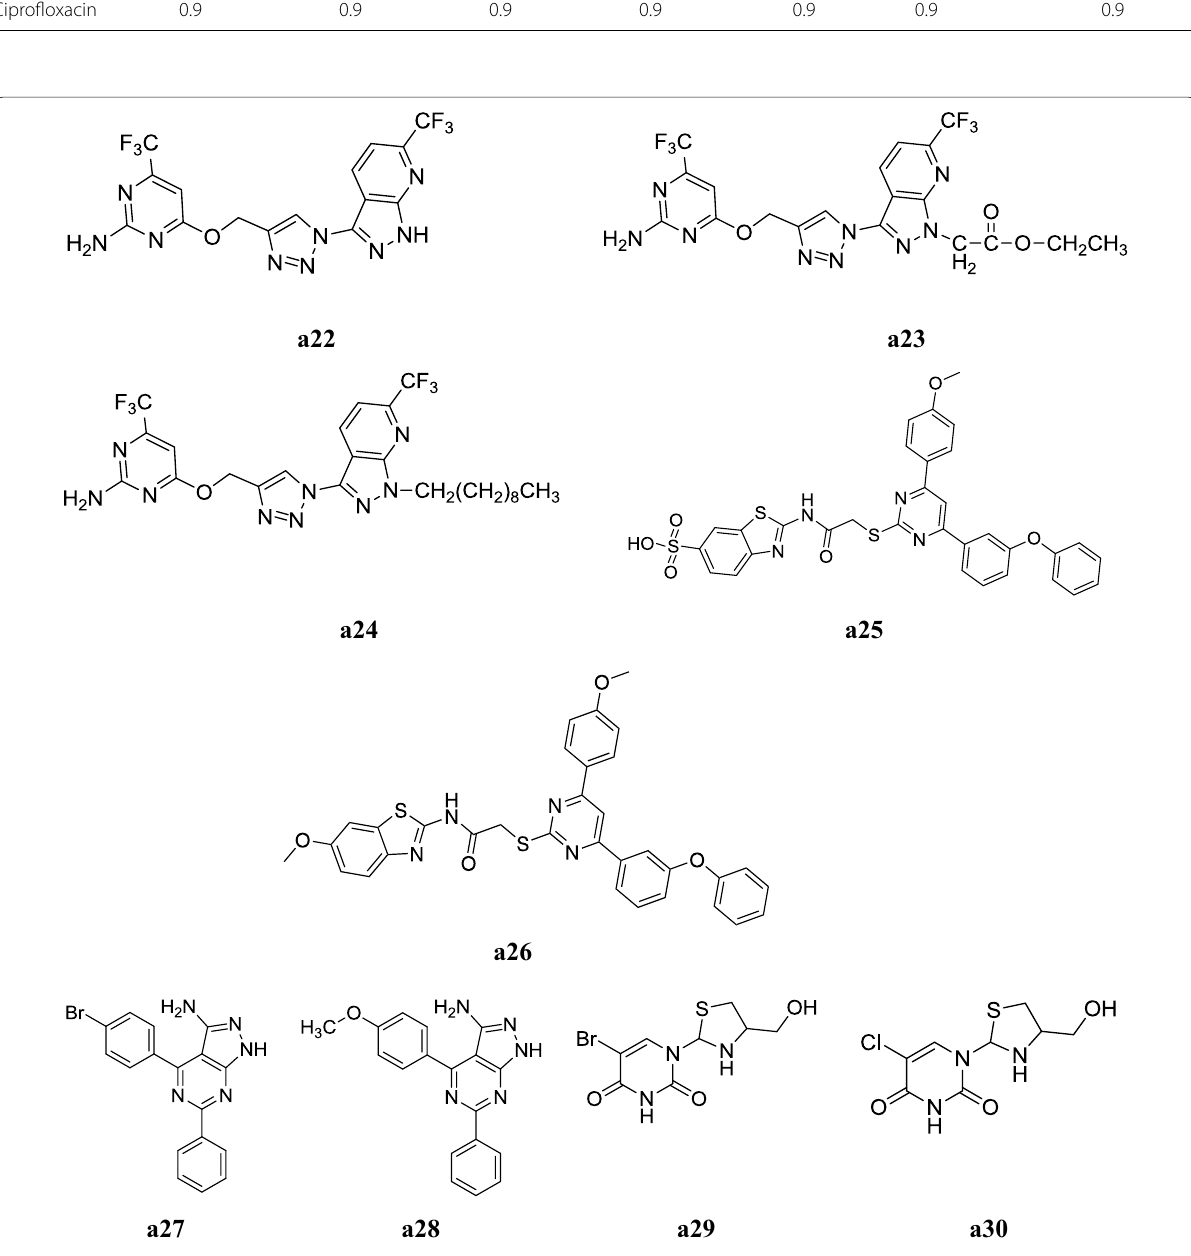
Fig. 4 Chemical structure of the most active antimicrobial pyrimidine derivatives ( a22 – a30